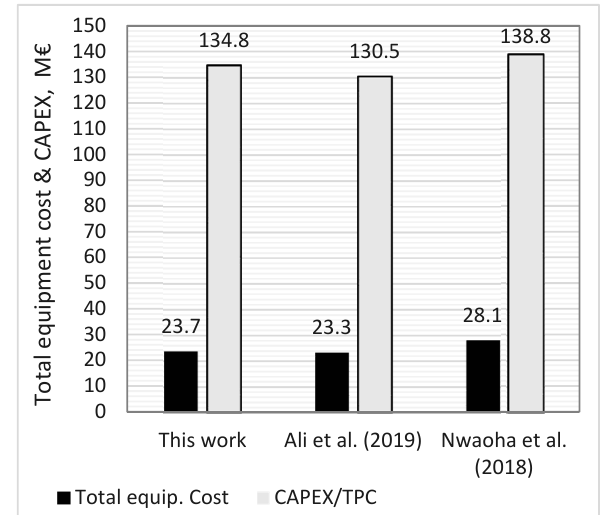
Figure 2. Comparison of total equipment cost and total capital investment (CAPEX) with other studies.